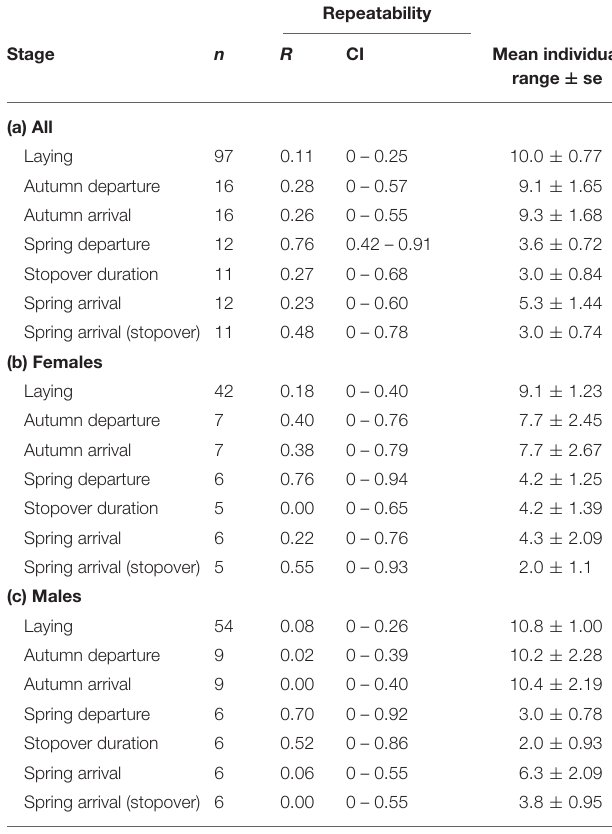
TABLE 2 | Repeatability ( R ) with 95% confidence intervals (CI) of timing of annual events and spring stopover duration, for all individuals (a) and by sex (b and